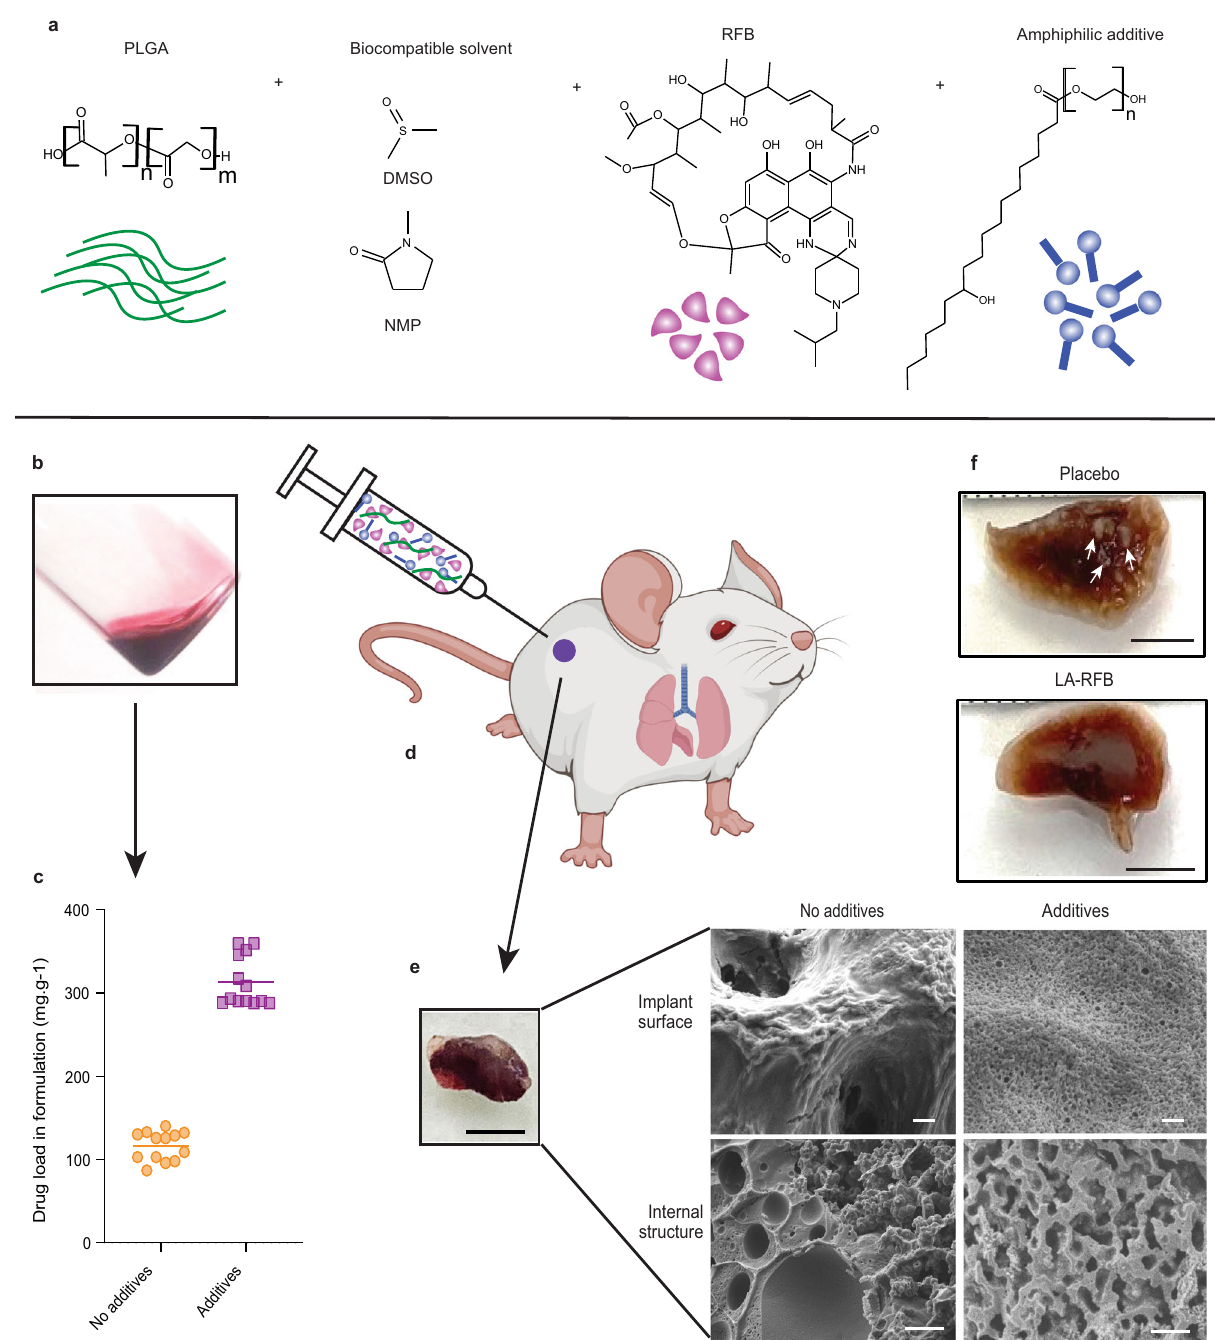
Fig. 1 | Criticalchanges inthe materialcompositionofin situ formingimplant formulations result in structural changes, increased payload, reduced ero- sion, and long-term effective drug delivery. a Schematic showing LA-RFB compositionconsistingofPLGAasthebiodegradablepolymer,DMSOorNMPas a biocompatible solvent, RFB as an active pharmacological ingredient, and Kol- liphor ® HS 15 as an example of an additive. b The liquid injectable LA-RFB. c The drug load increases in LA-RFB formulations after addition of amphiphilic addi- tives, n =13 per group, mean value are shown, P =0.0001, d The LA-RFB for- mulation can be administered subcutaneously and solidi fi es after injection. e A solidi fi ed implant of 50 μ L LA-RFB, scale bar is 5mm, and microphotographs of